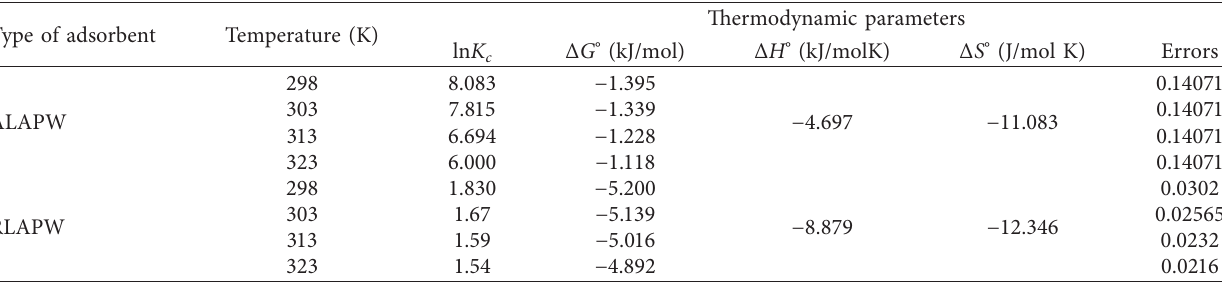
Table 2: The values of thermodynamic